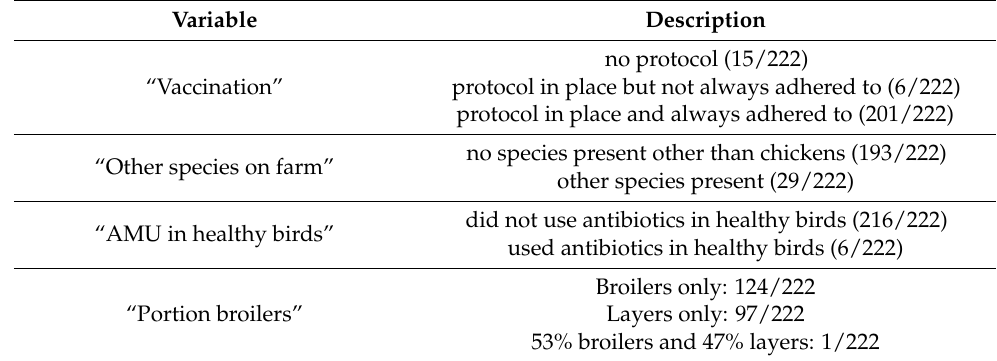
Table 1. Summary statistics of categorical variables.